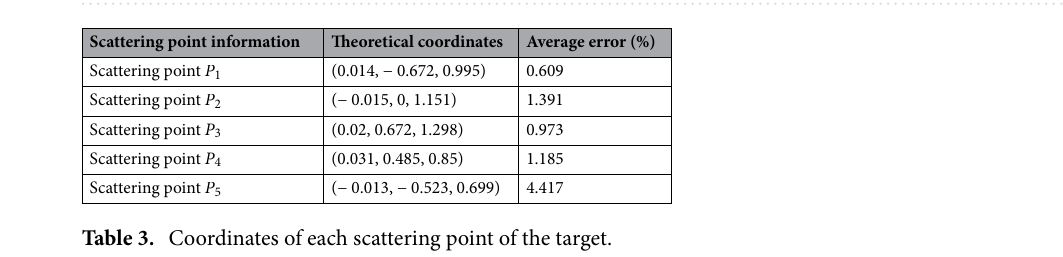
Figure 7. Comparison of two-dimensional images. ( a ) Two-dimensional images before compensation. ( b ) Compensated two-dimensional images.